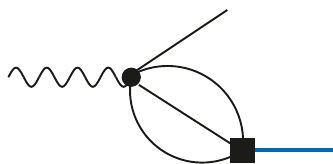
Figure 6 . A Feynman diagram that does not contribute to the absorptive parts of the form factors W + ;S ( z ) at two loops, but which gives imaginary parts to a + ;S and to b + ;S . The meaning of the lines and of the vertices is as in (cid:12)gure